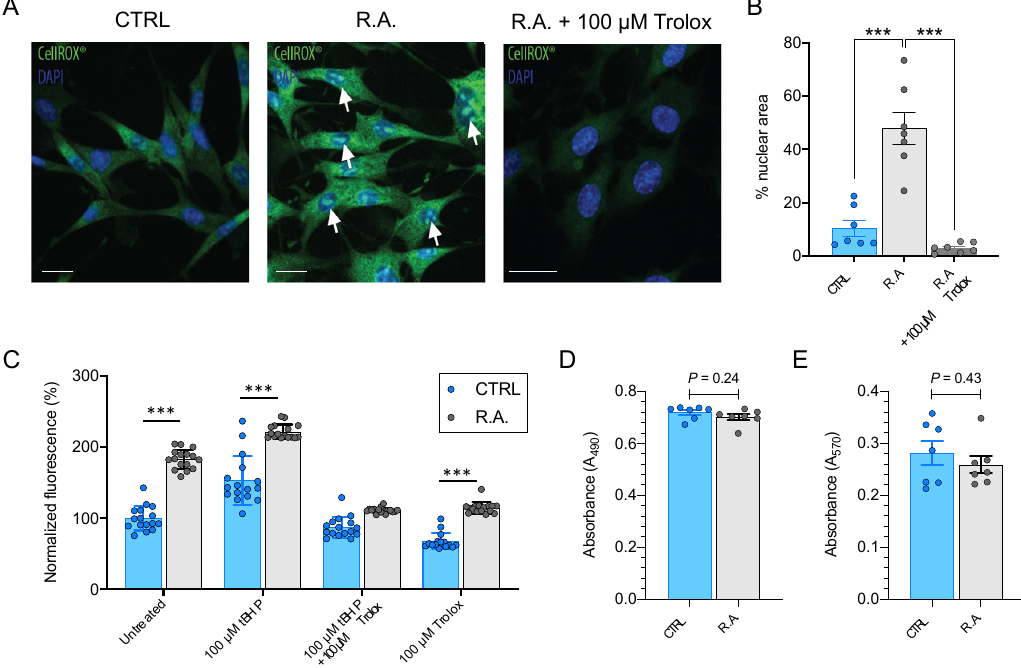
Figure 2. Reactive astrocytosis results in elevated cellular levels of oxidative stress. ( A ) Representative images of CellROX ® Green staining for ROS generation. Increased nuclear and cytosolic fluorescence were observed in activated optic nerve head astrocytes compared to control. Pretreatment with 100 µ M Trolox for 1 h prior to the induction of reactive astrocytosis prevented this increase in oxidative stress. White arrows point to nuclear fluorescence indicative of ROS generation. ( B ) ROS generation was quantified as percentage of nuclear area covered by CellROX ® Green fluorescence ( n = 7; One-Way ANOVA with Tukey’s multiple comparisons test, p < 0.001). Trolox prevented this increase ( n = 7; P < 0.001). ( C ) Dichlorofluorescein fluorescence increased significantly during reactive astrocytosis ( n = 16, p < 0.001). Pretreatment with a sublethal (100 µ M) dose of t BHP for 1 h prior to and during induction of reactive astrocytosis further increased cellular levels of oxidative stress ( n = 16, p < 0.001). Trolox prevented both the t BHP- and reactive-astrocytosis-induced upregulation of oxidative stress ( p > 0.05). Sixteen individual replicate datapoints are shown, representative of three separate experiments. Data were analyzed by Two-Way ANOVA ( p < 0.001) with results from Sidak’s multiple comparisons test indicated by asterisks. ( D ) Induction of reactive astrocytosis did not result in a loss of cell viability, as determined by comparing absolute LDH release by measuring A 490 in control and activated optic nerve head astrocytes ( n = 7, p = 0.24). ( E ) Similarly, there was no statistically significant difference in MTT absorbance (A 570 ) between control and activated optic nerve head astrocytes ( n = 7, p = 0.43). Data are shown as mean ± s.e.m. *** p < 0.001. CTRL = control; R.A. = reactive astrocytosis. Scale bar = 10 µ m.